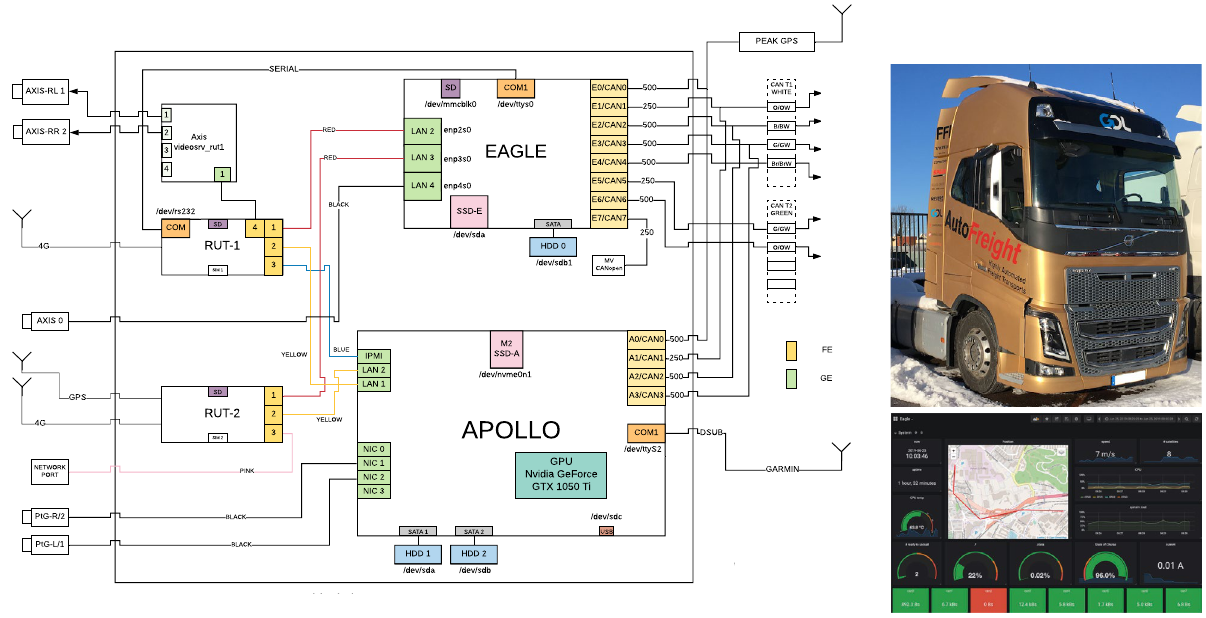
tion or due to one failing computing node. The system is accessible only via an encrypted maintenance channel; in addition, a separate encrypted channel is used to upload the collected data for data analytics in the